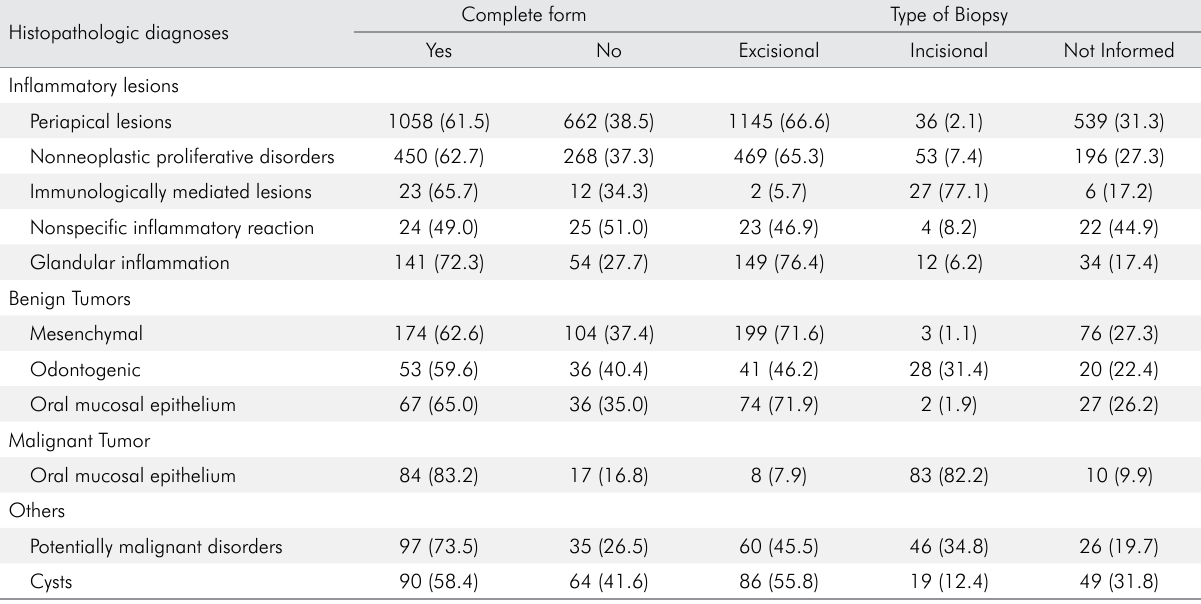
Table 3. Distribution (percentage in parentheses) of completeness of biopsy forms and type of biopsy for the most frequent histopathologic